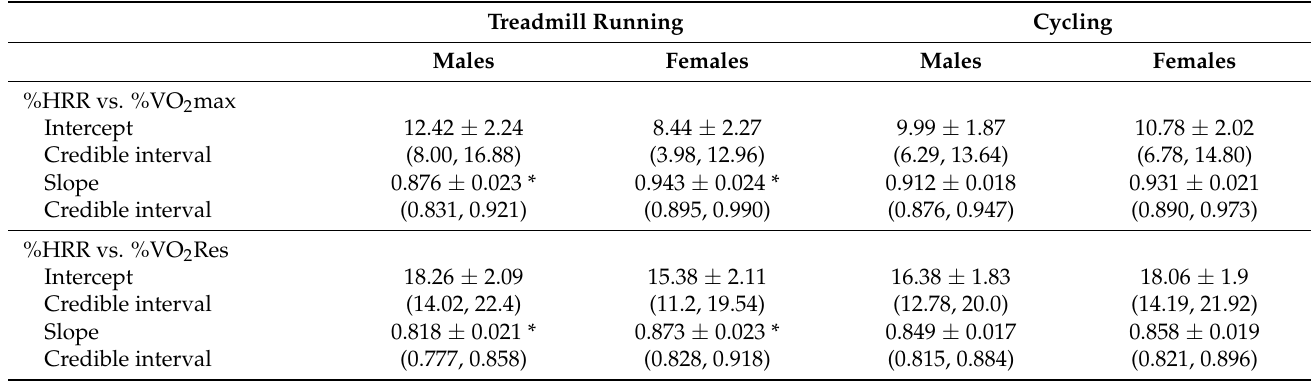
Table 3. Bayesian analysis of the HR–VO 2 relationship.